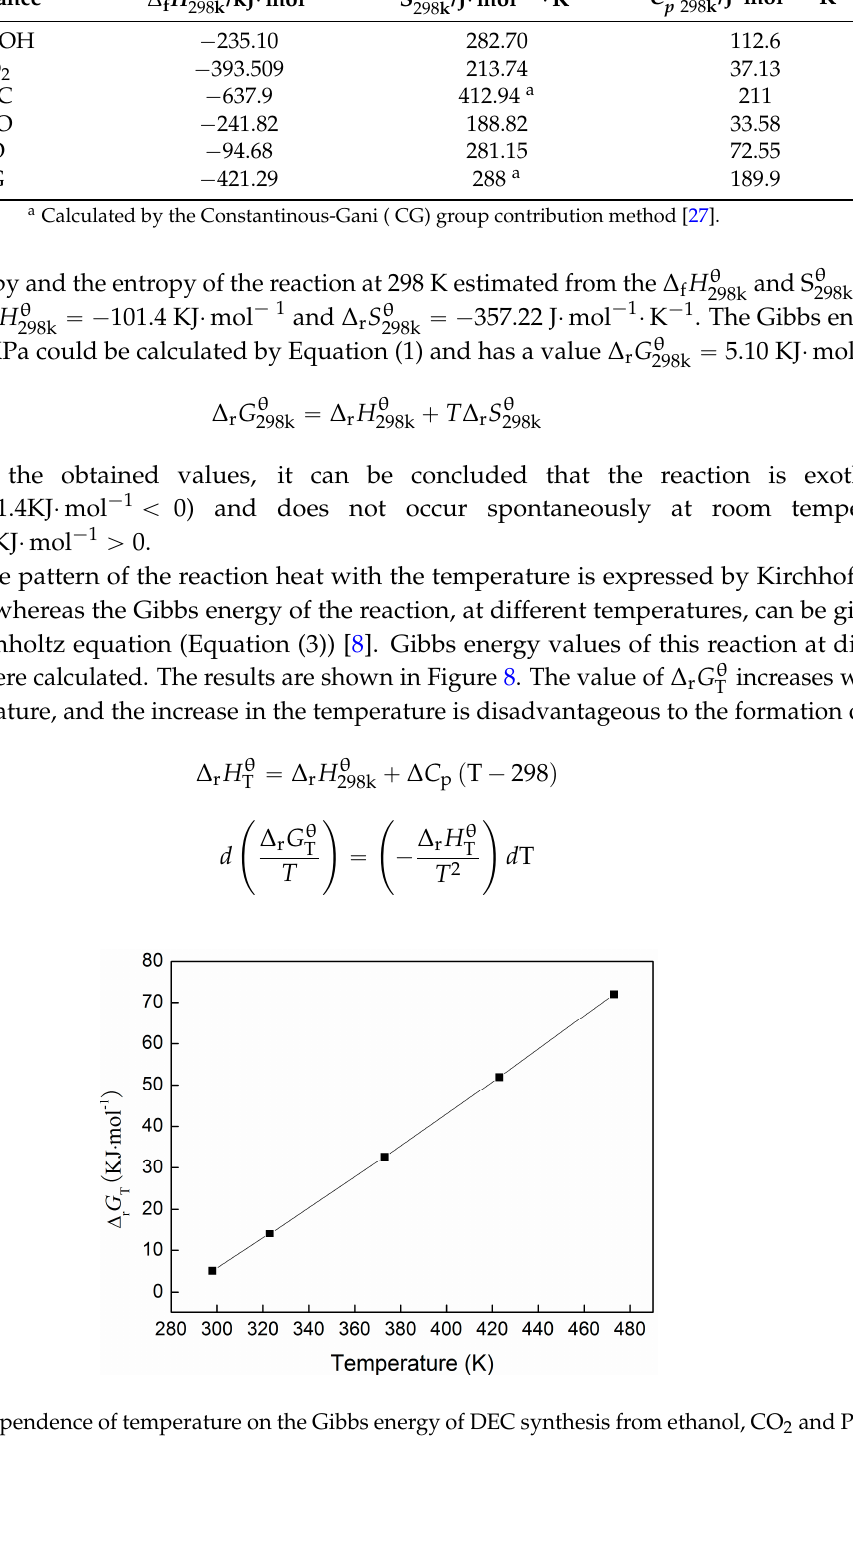
Table 2. Thermodynamic data of various substances in the reaction [26].